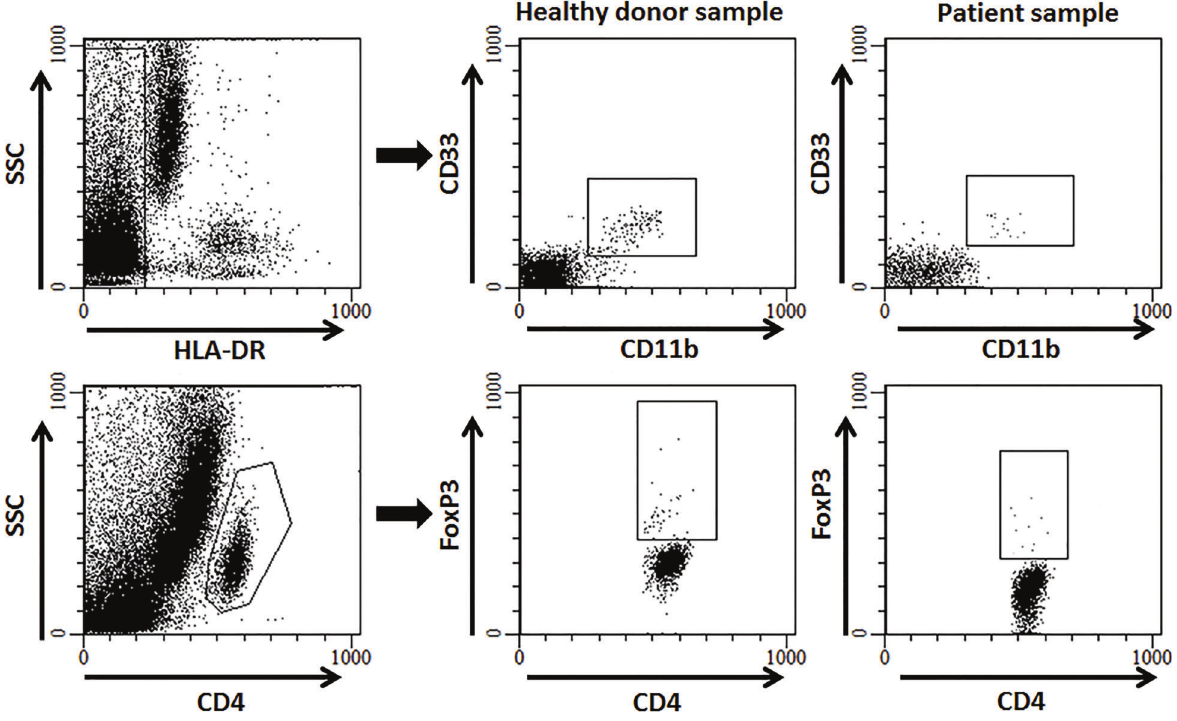
Figure 1. Representative fl ow cytometry showing labelling and gating strategies for myeloid-derived suppressor cells (MDSC) ( top ) and regulatory T (Treg) cells ( bottom ). MDSCs were de fi ned as CD33 + /CD11b + /HLA-DR- cells. Treg cells were de fi ned as CD4 + /FoxP3 +